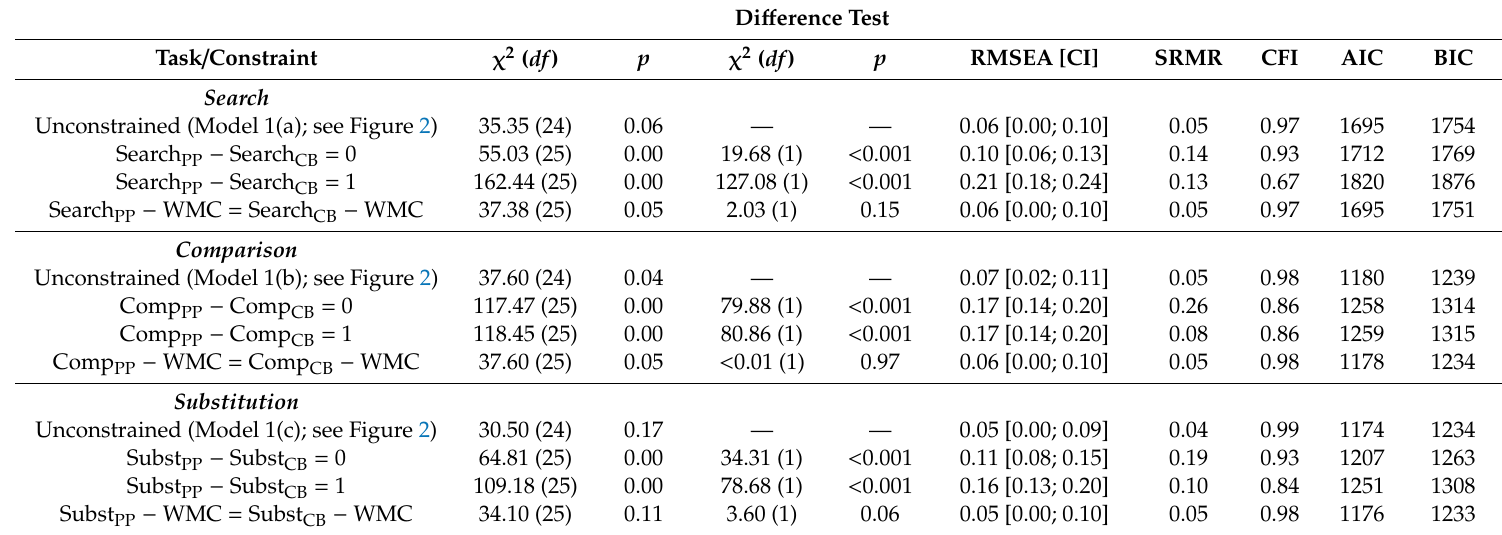
Table A1. Fit of single task